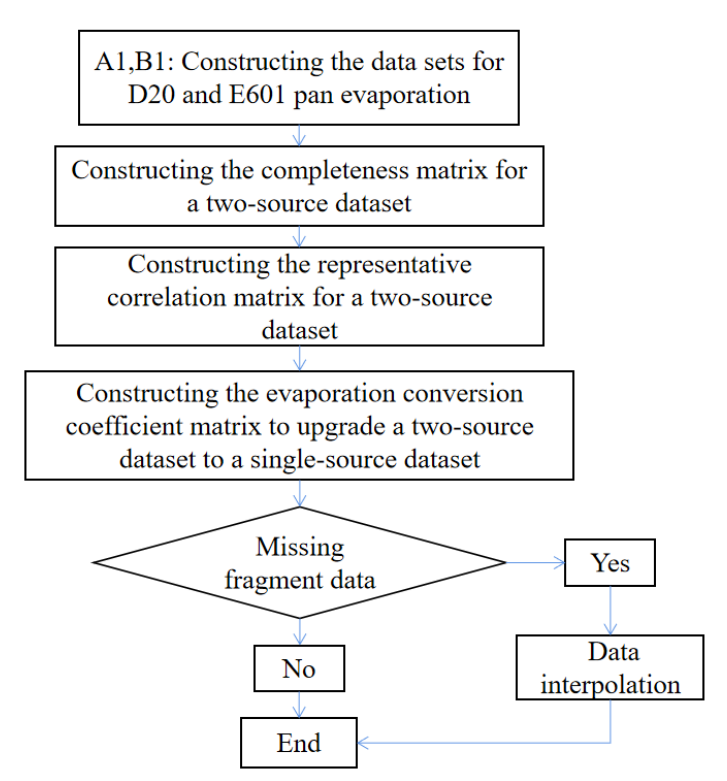
Figure 3. Governance and improvement method process for dual-source evaporation